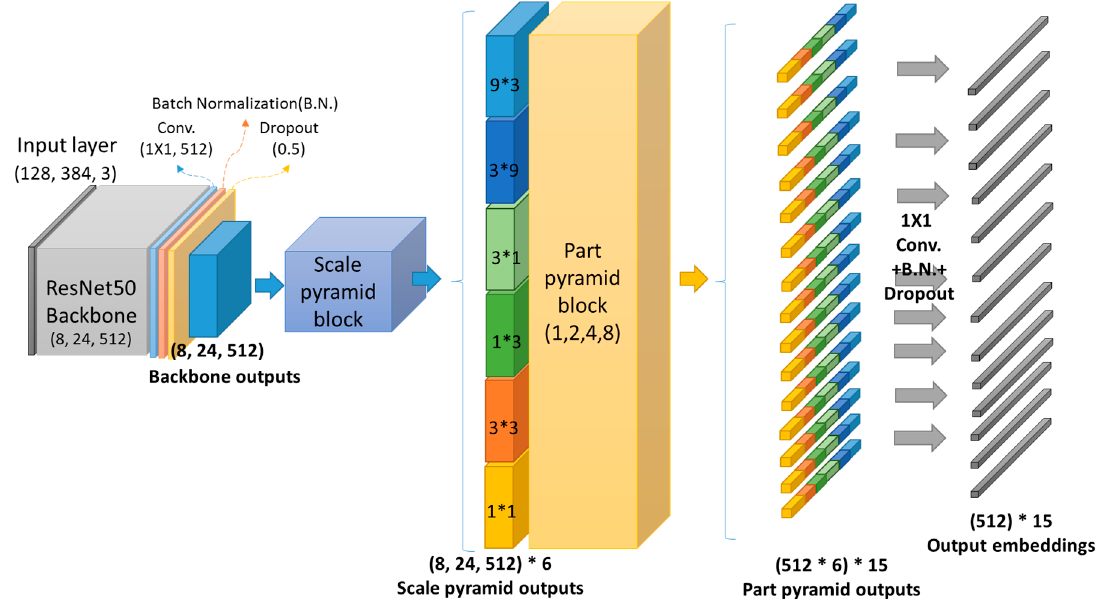
Figure 2. Network architecture of the proposed person re-identification model.